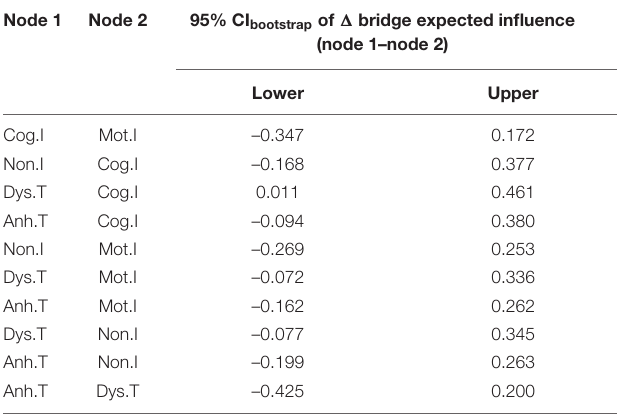
TABLE 4 | Bridge expected influence comparisons of each